Question: Describe this figure in one sentence.
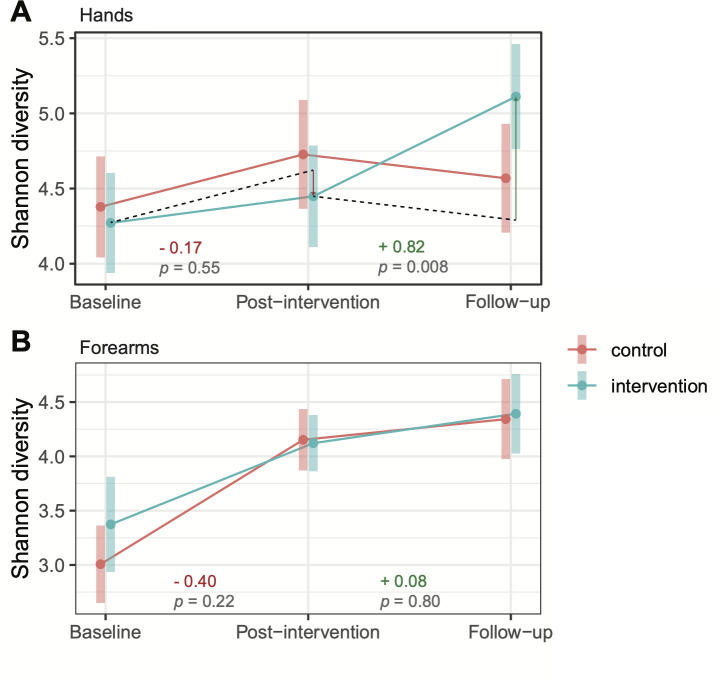
Answer: Alpha diversity for group × time point. Interaction plot of Shannon diversity (estimated marginal means) across groups (pink = control, blue = intervention) and time points (baseline, post-intervention: after 10 days of antiseptic use, and follow-up 3 weeks after cessation) in ( A ) hands and ( B ) forearms (untreated control site). The interaction estimate for each time period is annotated along with the P value. Error bars indicate 95% confidence intervals around the means. Dotted lines in panel A demonstrate the counterfactual (where the intervention group would be without the intervention), and arrows are added for visualization of the treatment effect.